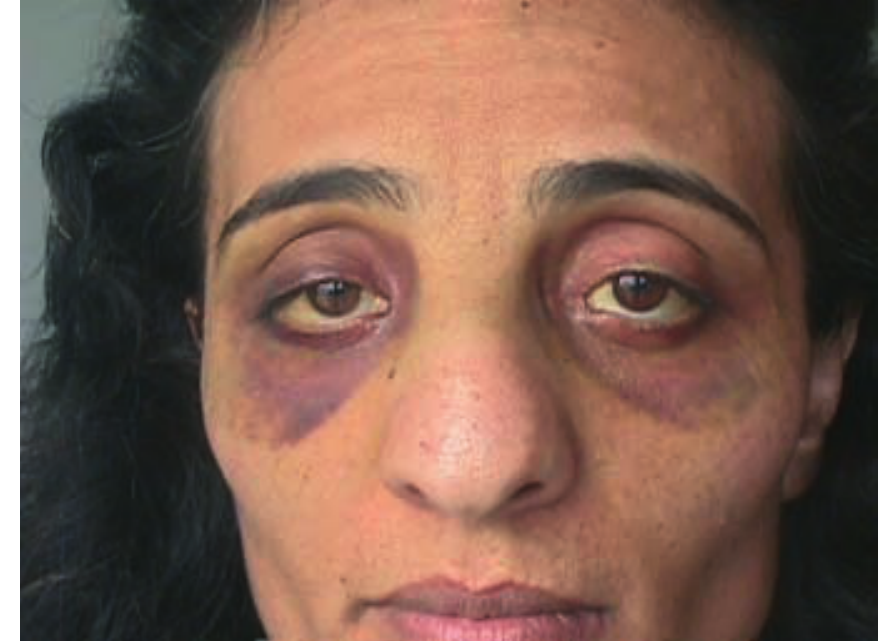
Patient with raccoon’s eyes. This picture was taken 1 day after plucking of eyebrows. The patient has given her consent for the publication of this article and the